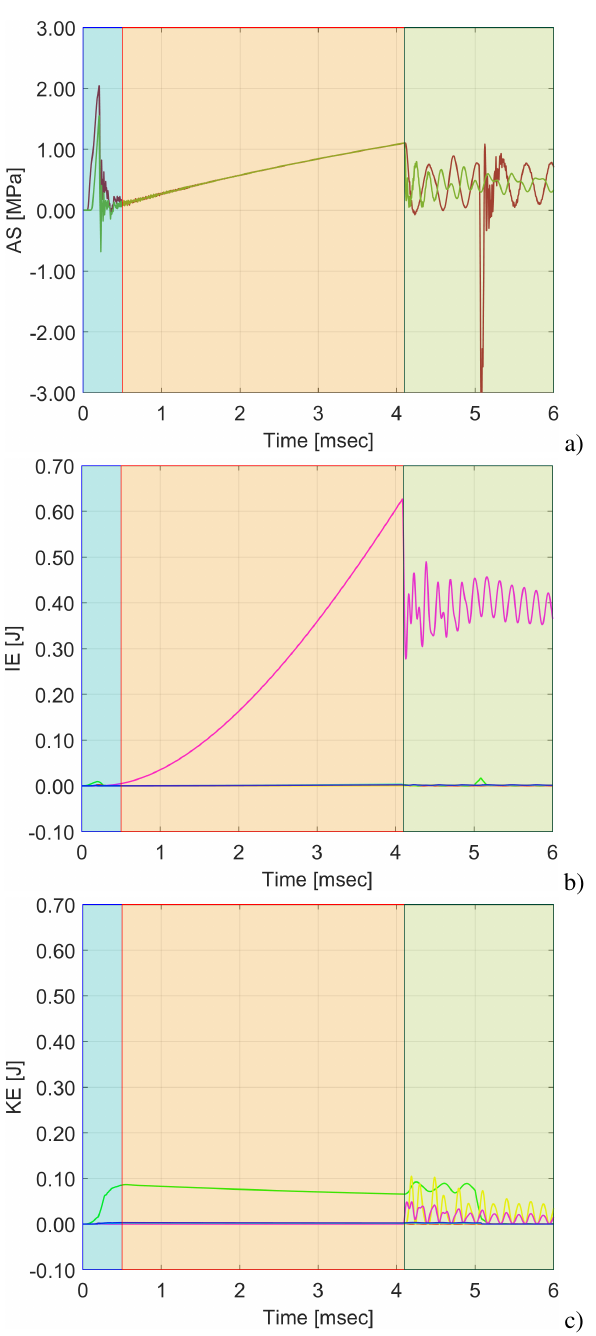
Figure 4. Natural rubber aggregate (a) AS: input (red) and output (green) axial stress pulses (b) IE: internal energy (c) KE: kinetic energy. For internal and kinetic energy the colormap is the following: green and red are used for output and input bars respectively, yellow for the core, magenta for the coating, and blue and light blue for the concrete